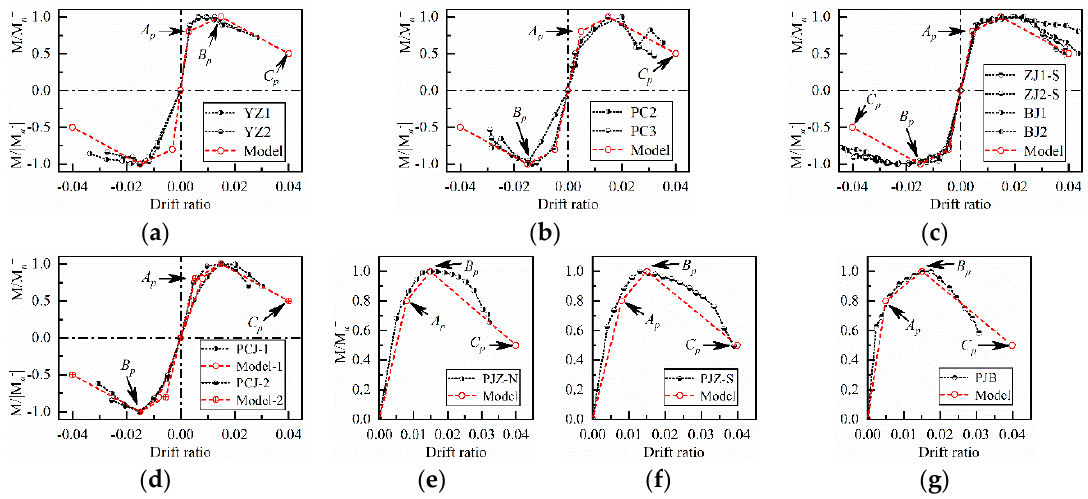
Figure 8. Validation of dimensionless model: ( a ) Wu et al. [30]; ( b ) Shariatmadar and Zamani [31]; ( c ) Liu et al. [32]; ( d ) Zhang [33]; ( e )–( g ) Yang